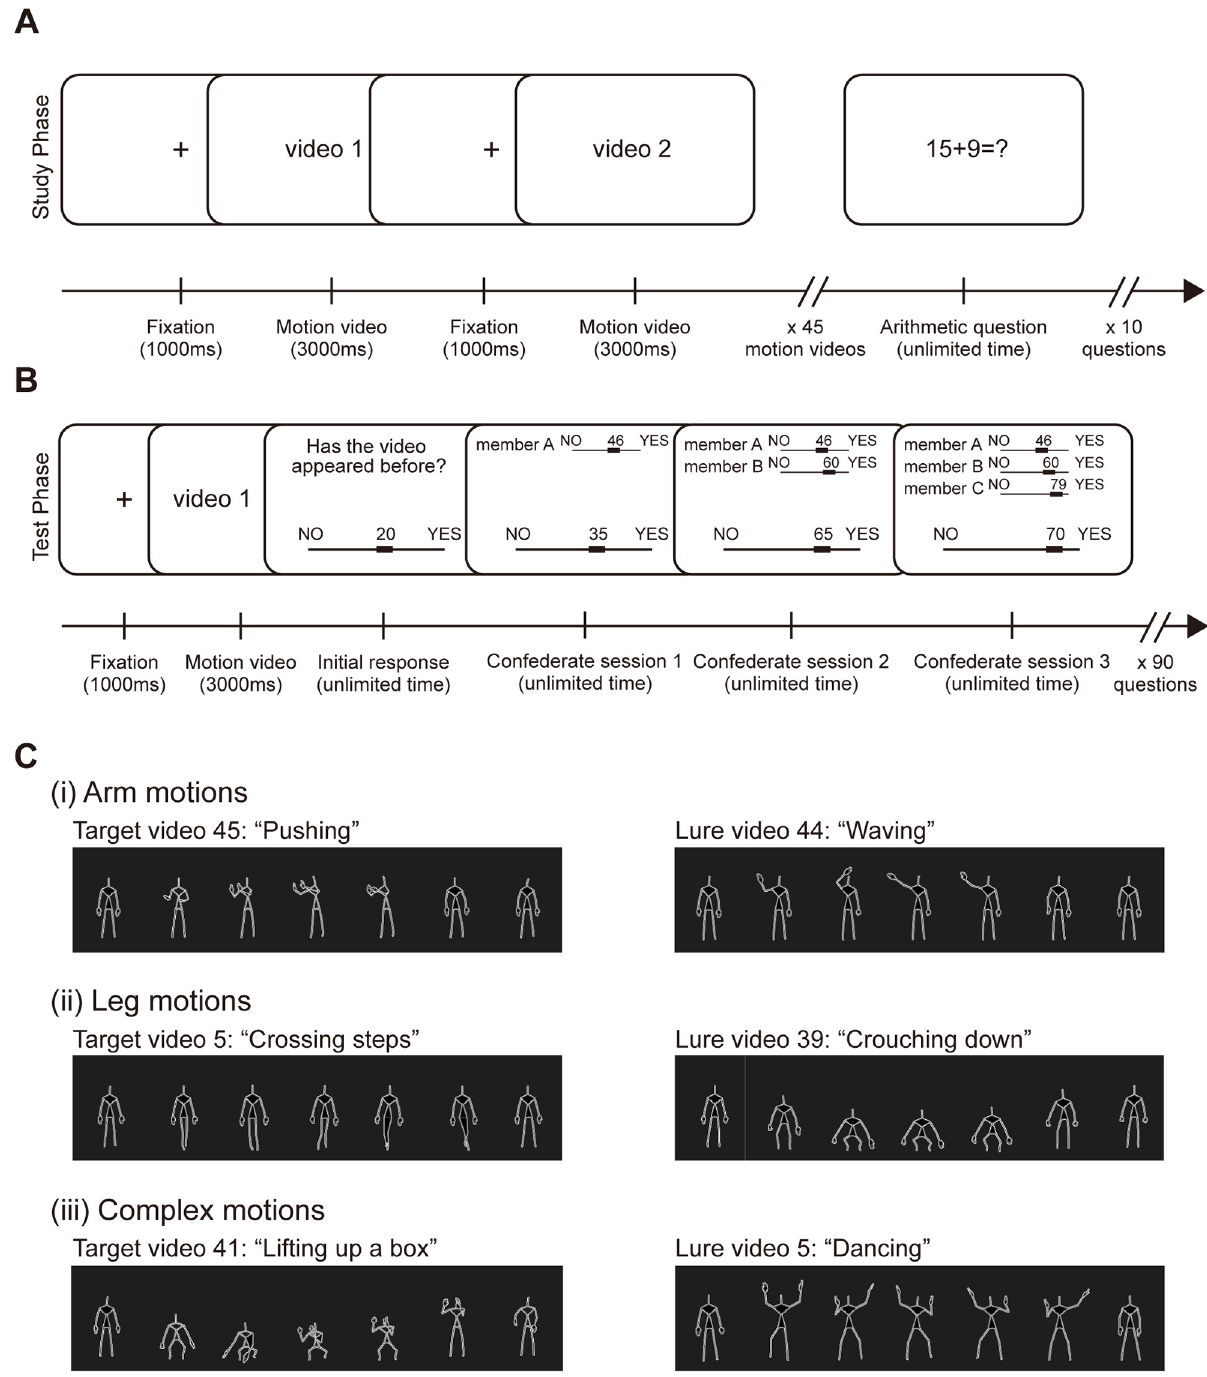
Fig 1. Experimental design. (A) Study phase of the experiment. Participants were required to memorize a total of 45 three-second skeletal motion videos appearing in random orders, followed by answering 10 arithmetic questions to prevent memory rehearsal. (B) Test phase of the experiment, with altogether 90 questions (45 target and 45 lure videos). Participants were asked to indicate with a slider their answers and confidence to the question “Has the video appeared before?”. After the initial response, participants entered three consecutive confederate sessions. In each session, one additional computer-generated confederate confidence rating would be shown and participants would have a chance to change their slider value with the goal of getting the highest overall group score. (C) Examples of computer-rendered motion videos. The target and lure videos contained equal number of arm, leg and complex motions (see also S1